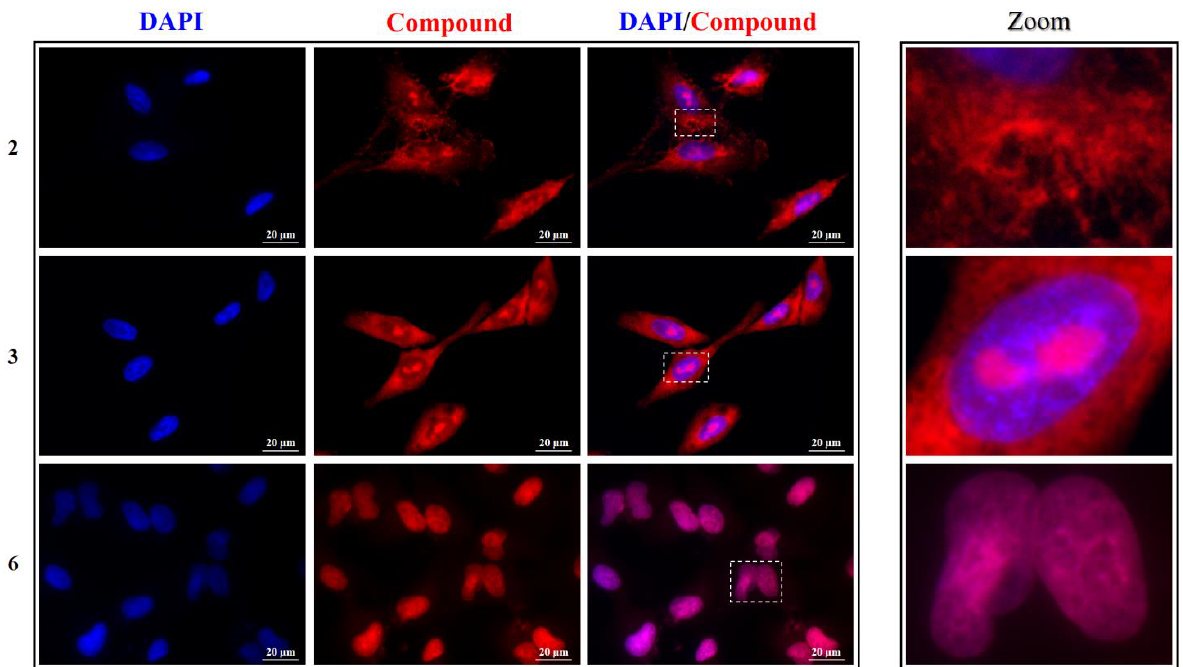
Figure 7. Left panel: representative fluorescence microscopy images of nuclei (DAPI, blue), com- pounds 2 , 3 , and 6 (red), and the relative merged images of A549 cells. Image magnification: 60×. Right panel: zoom-in of representative cells.